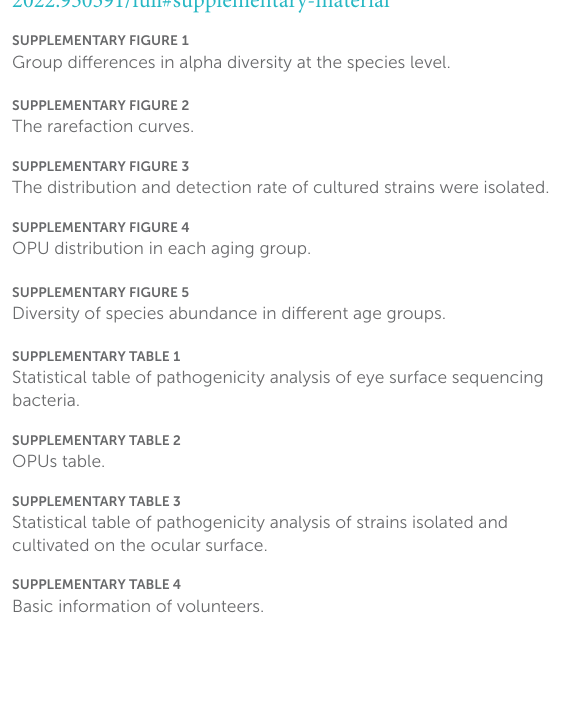
SUPPLEMENTARYFIGURE5 Diversity of species abundance in different age groups. SUPPLEMENTARYTABLE1 Statistical table of pathogenicity analysis of eye surface sequencing bacteria.